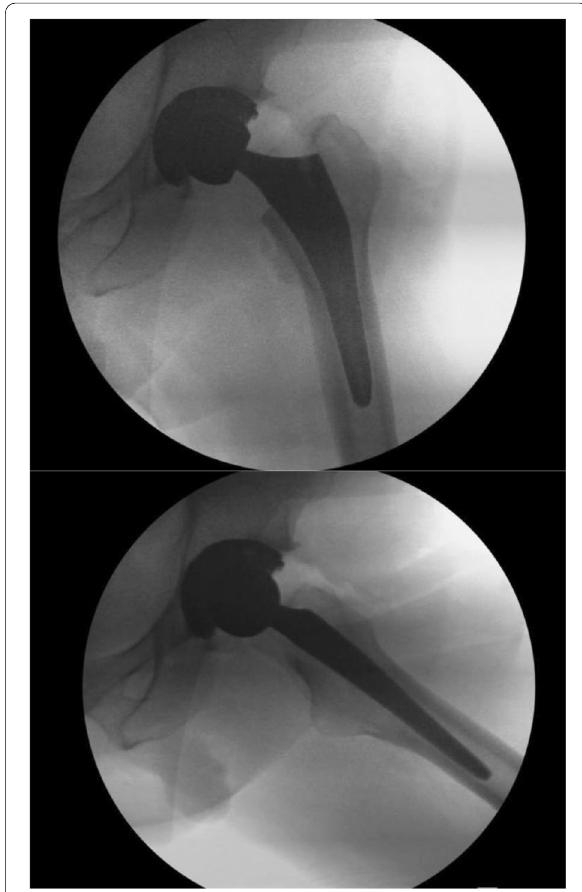
Fig. 10 Final fluoroscopy demonstrating proper implant